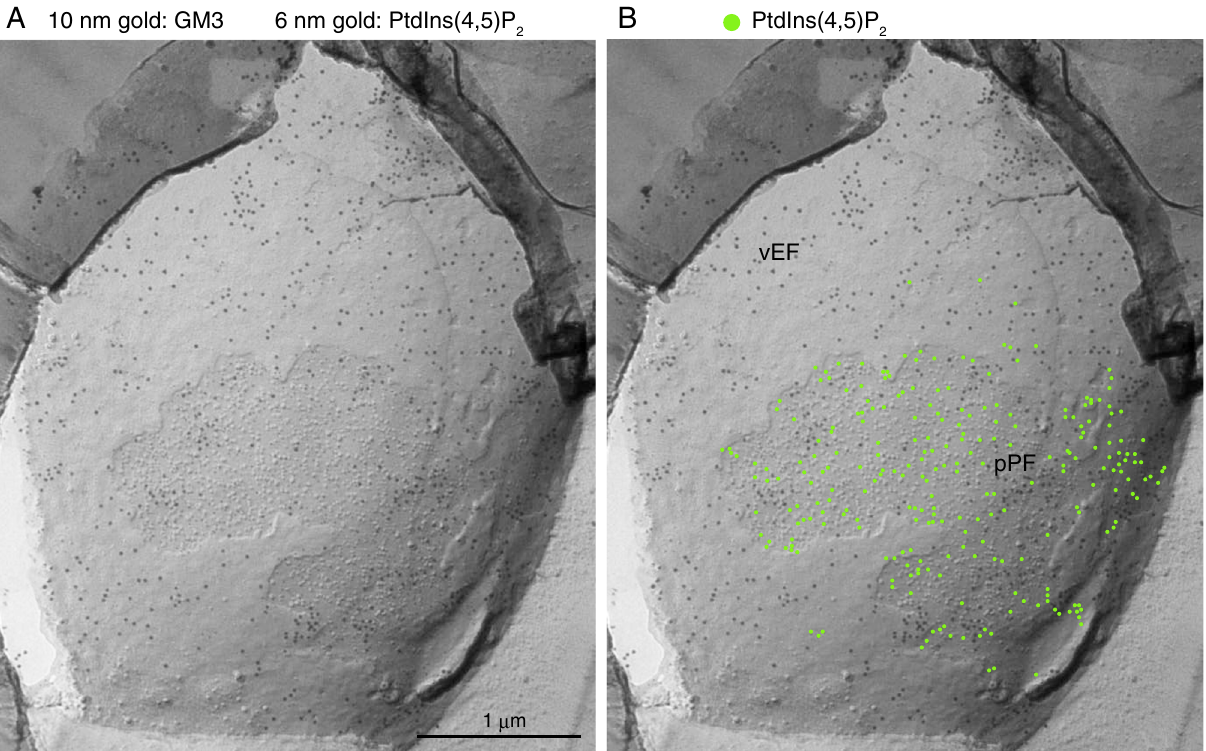
Figure 5. Double labeling of GM3 and PtdIns(4,5)P 2 on the PF in the P. falciparum plasma membrane. The replica of the P. falciparum plasma membrane was stained simultaneously with anti-GM3 antibody and GST- PLCδ1-PH, which specifically binds to PtdIns(4,5)P 2 . Labeling of GM3 (10 nm gold) and PtdIns(4,5)P 2 (6 nm gold, green dots in B) were colocalized on the PF in the P. falciparum plasma membrane. Scale bars: 1